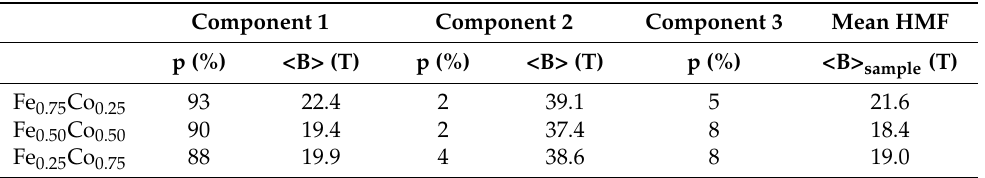
Figure 4. ( a ) Room temperature Mössbauer spectra collected for non-annealed Fe-Co nanochains, and ( b ) their correspond- ing hyperfine magnetic field distributions; component 1—green line, component 2—red line, component 3—violet and blue lines. Table 2. Parameters of components of Mössbauer spectra collected for non-annealed Fe-Co nanochains: p—relative intensity, <B>—mean HMF. Components: component 1—low- and middle- field part of spectrum, component 2—high-field part of spectrum, and component 3—paramagnetic and/or superparamagnetic